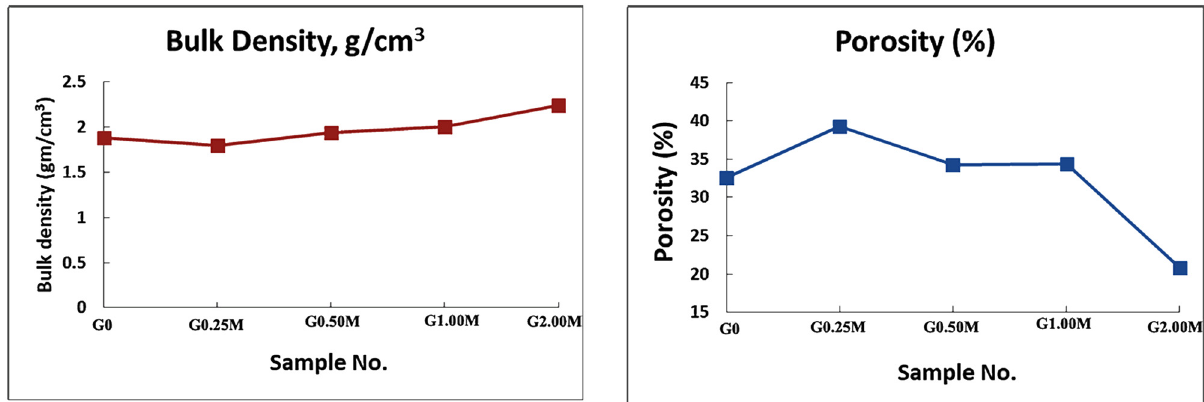
Figure 6: Densities and porosities of the samples sintered at 1,100°C/2 h.